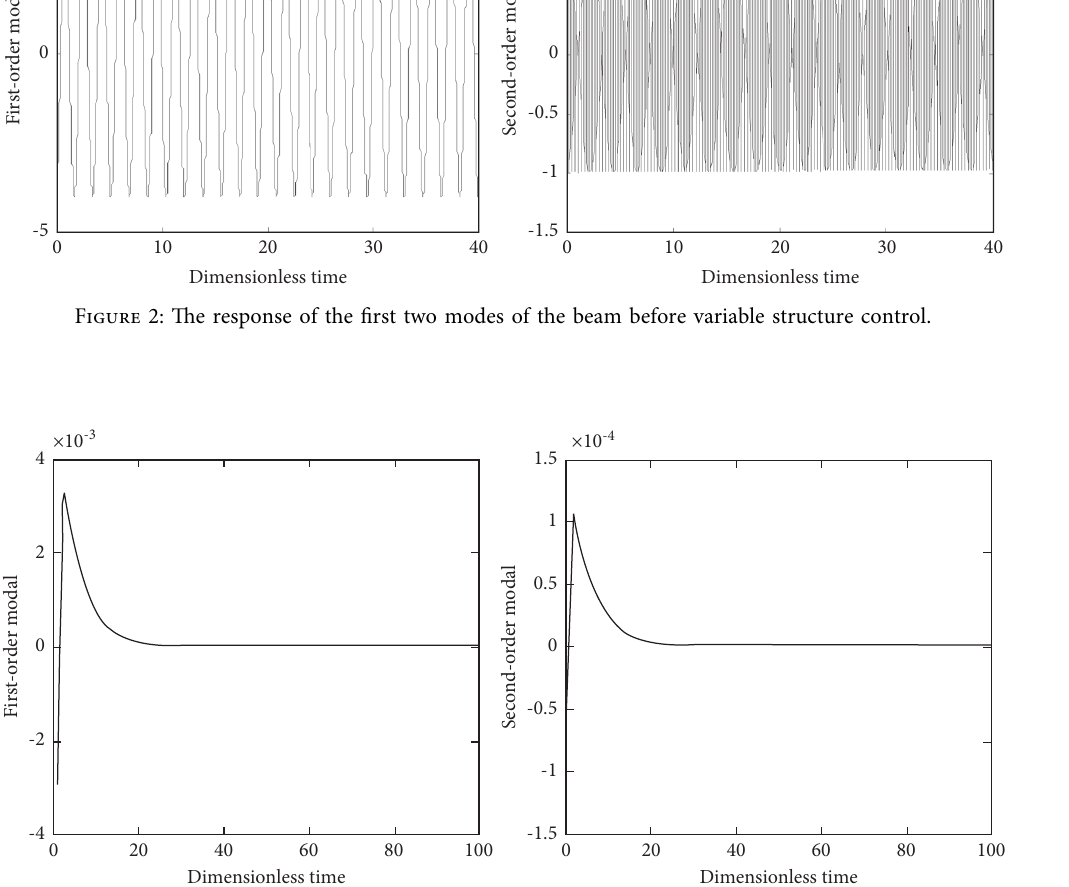
Figure 3: The response of the first two modes of the beam after variable structure